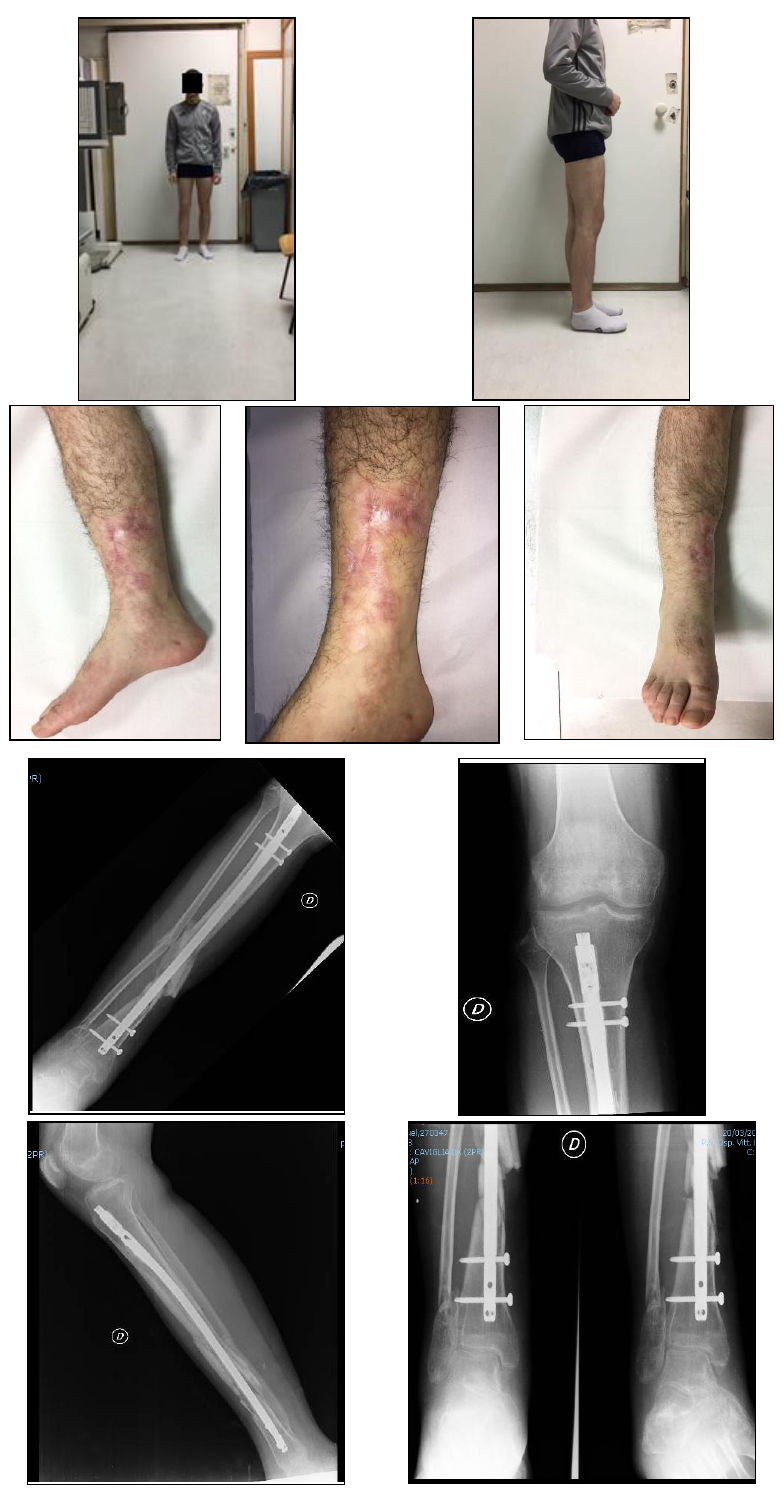
Figure 10. Clinical-radiographic follow up in February 2017.